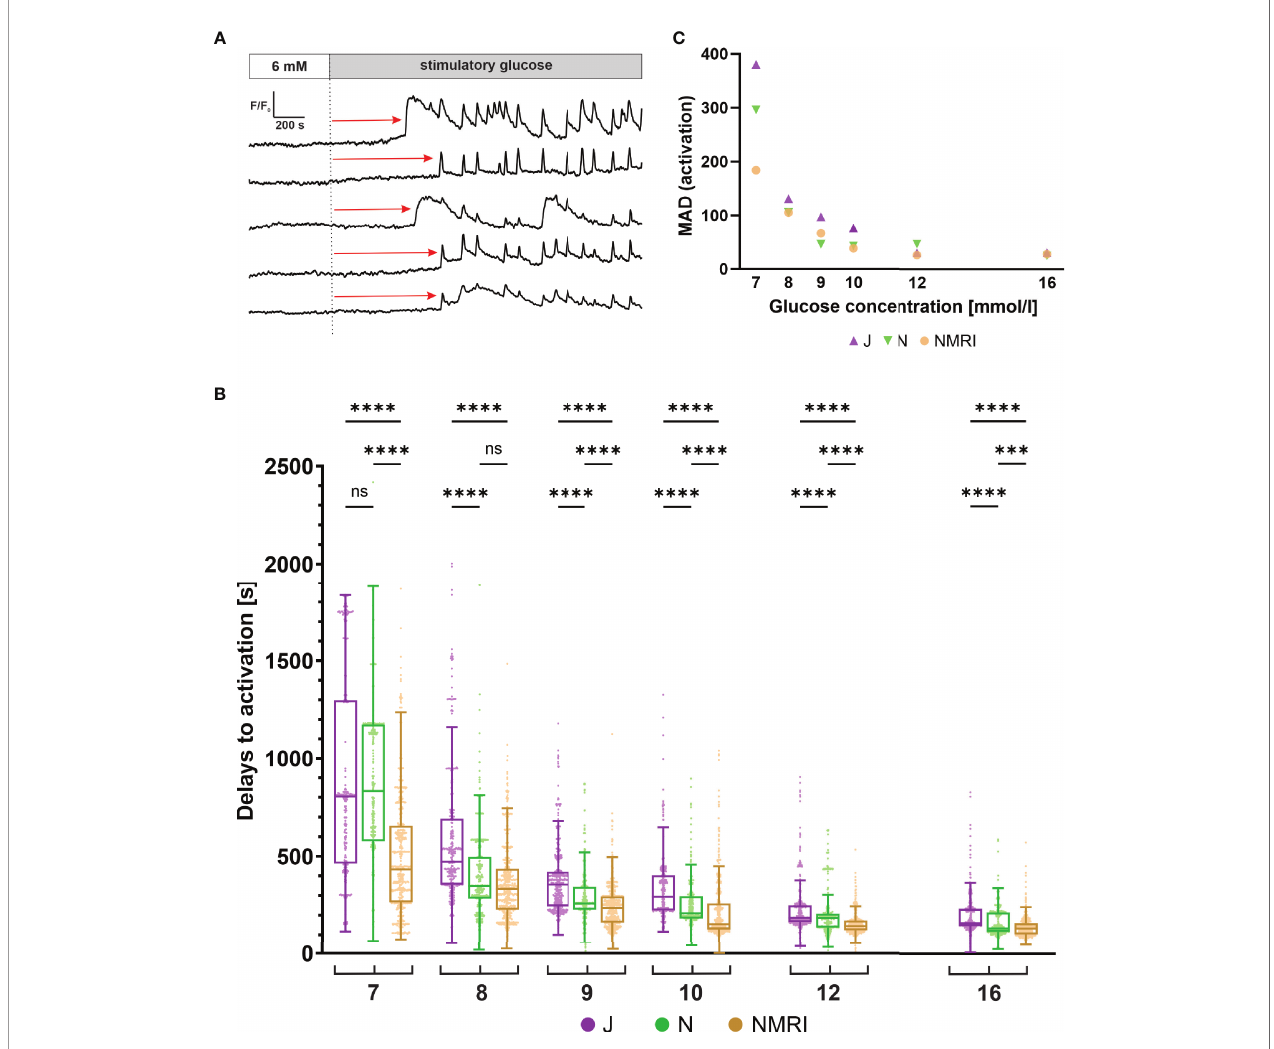
FIGURE 2 | Glucose-dependent activation delays of beta cells in C57BL/6J, C57BL/6N and NMRI mice. (A) Schematic representation of delays in activation (red arrow) measured as the time of perifusion of the islet with stimulatory glucose (dashed line) before the increase in [Ca 2+ ] i signal. (B) Delays to activation in C57BL/6J (median 805, 472, 357, 294, 186, and 156 s), C57BL/6N (median 833, 349, 260, 210, 185, 129 s), and NMRI (median 434, 334, 236, 155, 145, and 129 s) at 7-, 8-, 9-, 10-, 12-, and 16-mM glucose, respectively. (C) Variability of activation delays, expressed as median absolute deviation (MAD) after stimulation with 7-, 8-, 9-, 10-, 12-, and 16-mM glucose. MAD values (in seconds): C57BL/6J: 380 (7 mM), 131 (8 mM), 98 (9 mM), 76 (10 mM), 31 (12 mM), and 31 (16 mM), C57BL/6N: 296 (7 mM), 106 (8 mM), 46 (9 mM), 43 (10 mM), 47 (12 mM), and 25 (16 mM), NMRI: 184 (7 mM), 105 (8 mM), 66 (9 mM), 39 (10 mM), 26 (12 mM), and 28 (16 mM). Pooled data (coded as C57BL/ 6JC57BL/6NNMRI) from the following number of cells/islets/pancreas preparations: 239/9/6| 643/13/6| 743/13/6 (7mM glucose), 370/10/7| 876/8/5| 730/12/6 (8 mM glucose), 657/11/7| 851/9/6| 1091/12/6 (9 mM glucose), 521/9/6| 756/9/5| 1078/10/6 (10 mM glucose), 681/11/7| 759/11/6| 904/10/5 (12 mM glucose), and 725/11/5| 703/8/5| 1061/11/6 (16 mM glucose). Where present, the following symbols in indicate p-values: *p < 0.05, **p < 0.01, ***p < 0.001, ****p < 0.0001; ns, not signi fi